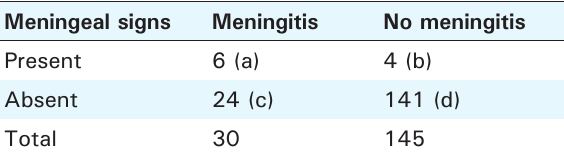
Table 2. Meningitis as predicted from meningeal signs Meningeal signs